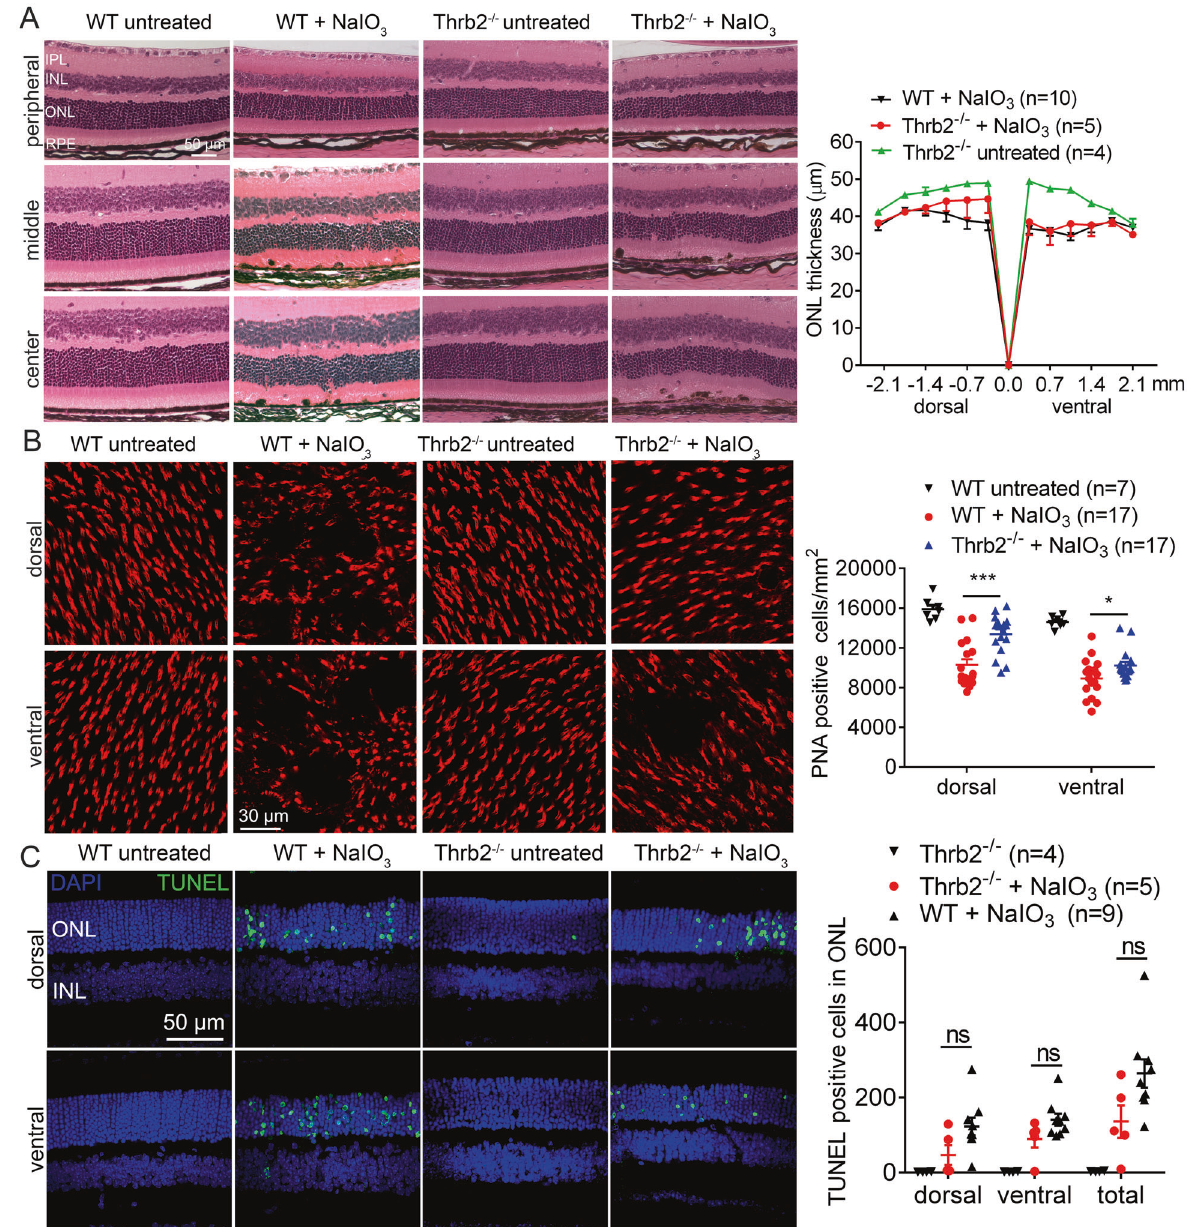
C Shown are representative confocal images of TUNEL labeling on retinal sections and corresponding quantitative analysis. Data are represented as means ± SEM for 4 – 17 mice per group (* p < 0.05, *** p < 0.001, compared with wild-type mice treated with NaIO 3